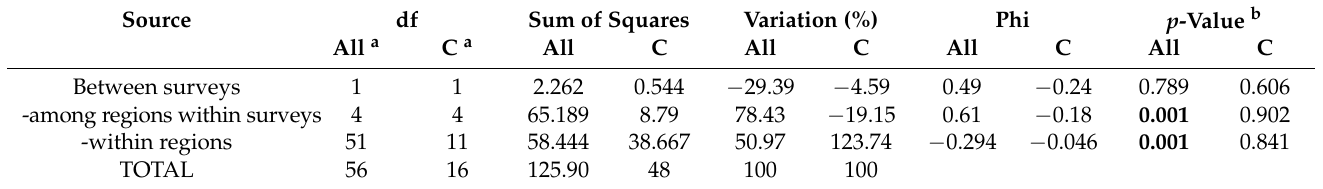
Table 5. Analysis of molecular variation (AMOVA) for Spanish population of Fusarium circinatum nested by surveys and geographic origin of isolates within surveys.